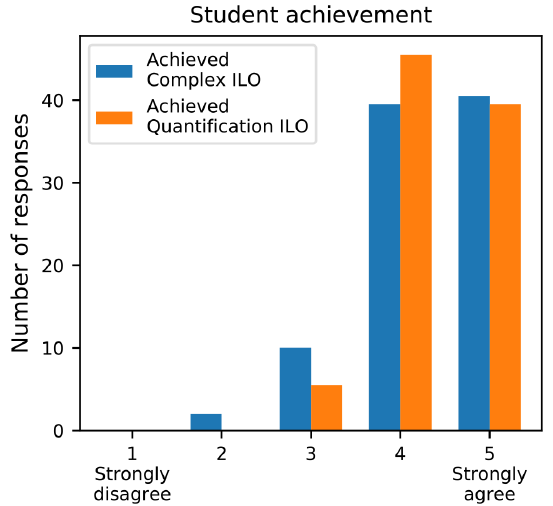
Figure 2. Student self-reported learning achievement. Distribution of pooled responses to student surveys over